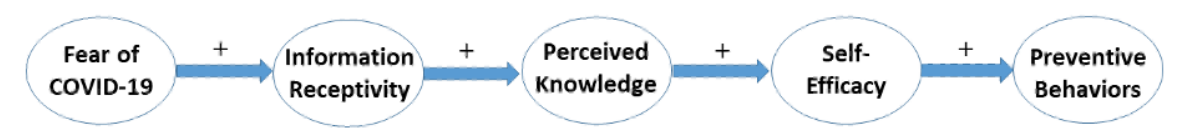
Figure 1. Conceptual